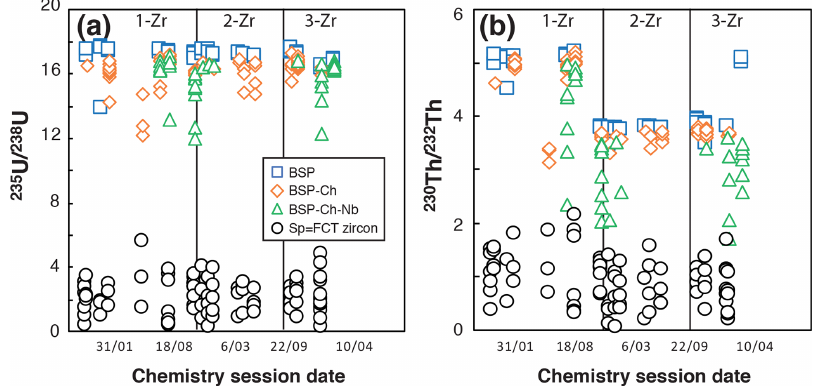
Figure 7. Evolution of the 235 U / 238 U and 230 Th / 232 Th ratios obtained for BSP, BSP-ch, BSP-ch-Nb, and FCT zircon solutions in different